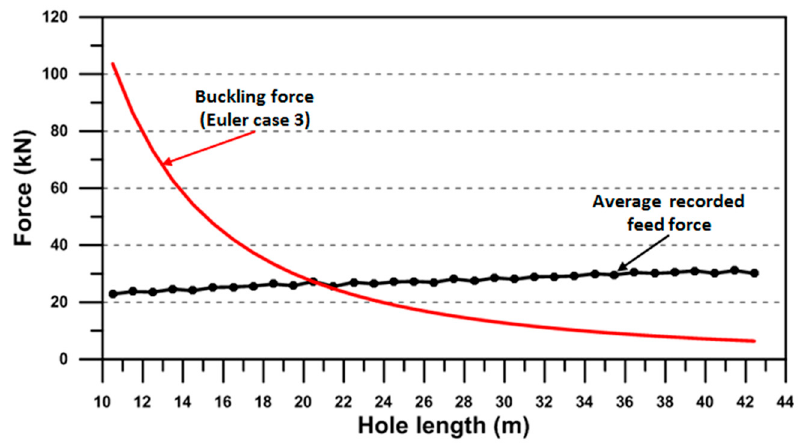
Figure 10. Drill string buckling force and applied feed force versus hole length.